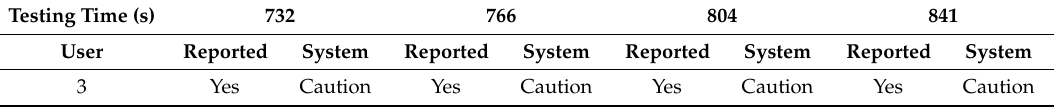
Figure 15. Comparison of heat stroke risk indicators for users feeling uncomfortable during the experimental tests (users 3 and 4). Table 10. Comparison between feedback data and system prediction results for user 3.